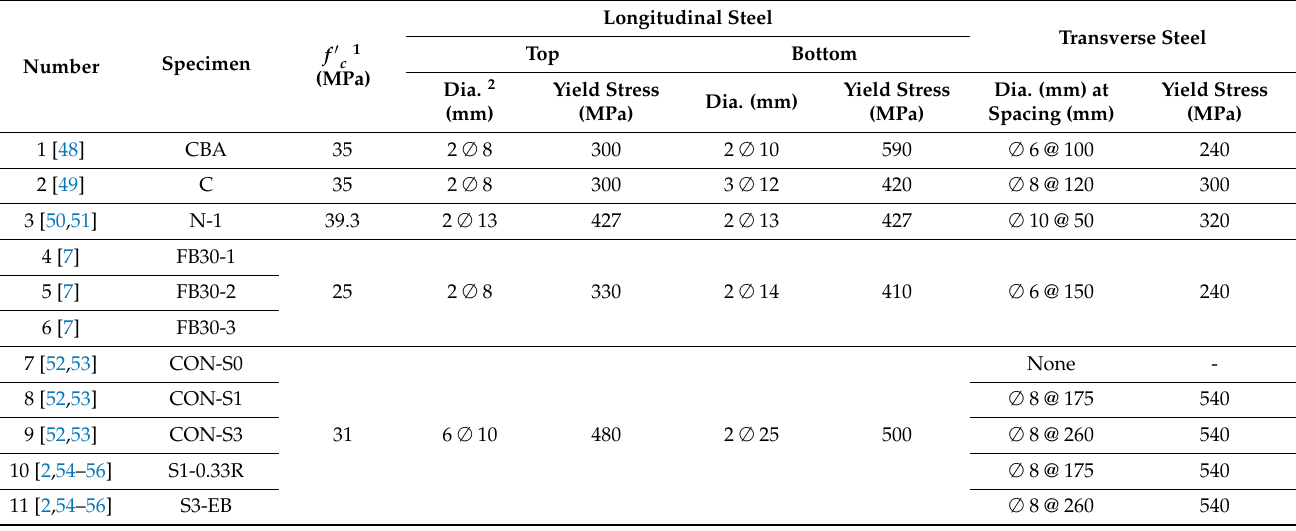
Table 3. Specimens Material Properties.